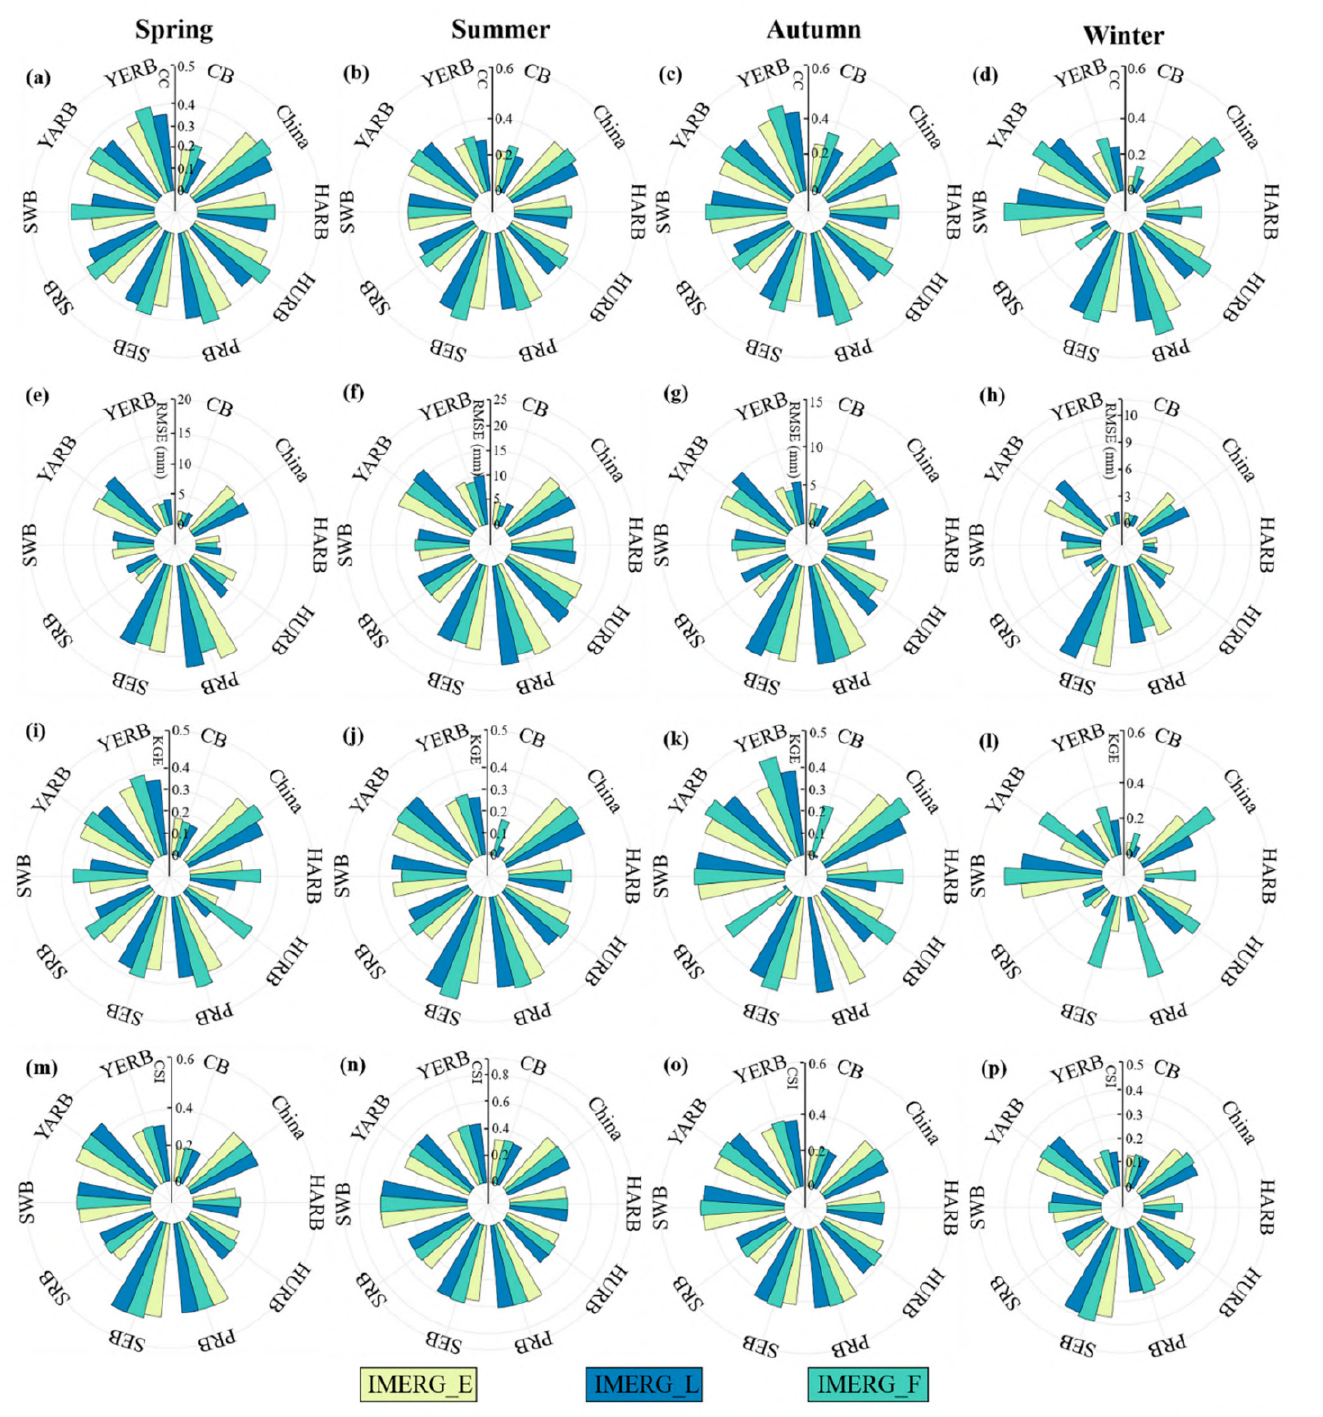
Figure 6. Radial column chart of CC ( a – d ), RMSE ( e – h ), KGE ( i – l ) and CSI ( m – p ) from IMERG_E, IMERG_L and IMERG_ F at the daily scale from 2008 to 2017 for different seasons over mainland China and nine basins (CB, Continental Basin; HARB, Haihe River Basin; HURB, Huaihe River Basin; PRB, Pearl River Basin; SEB, Southwest Basin; SRB, Songliao River Basin; SWB, Southwest Basin; YARB, Yangtze River Basin; YERB, Yellow River